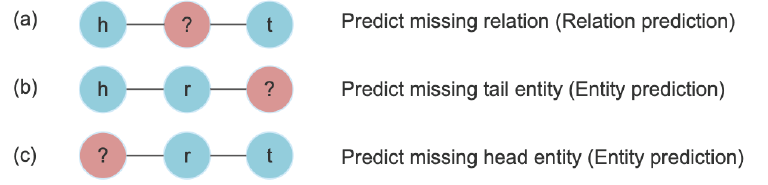
Figure 2. Link prediction and its sub tasks. For a given triple (h,r,t) ( a ) represents Relation prediction task and ( b , c ) represent Entity prediction task. Here, h is head entity, t is tail entity and r is